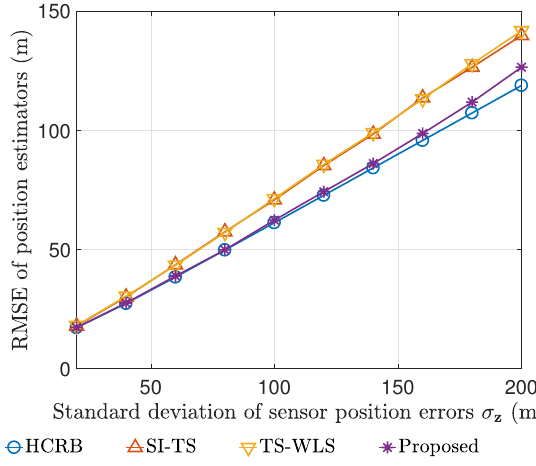
Figure 3. RMSE and HCRB for position estimator.